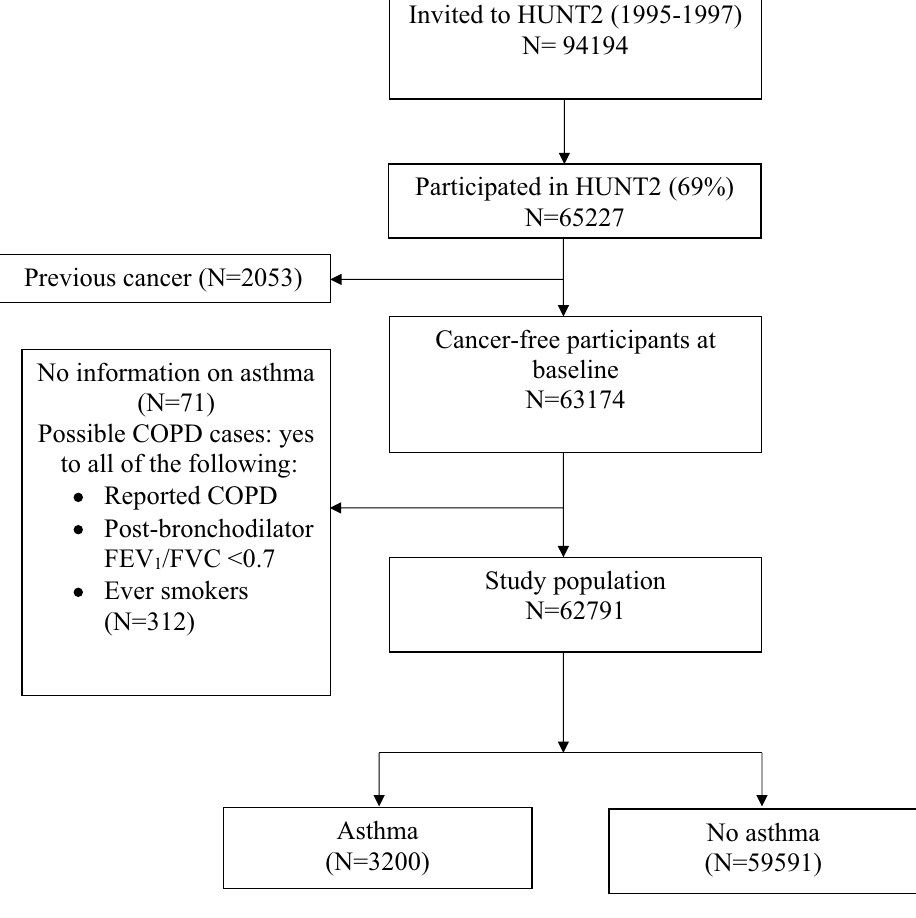
Figure 1. Flow chart of study